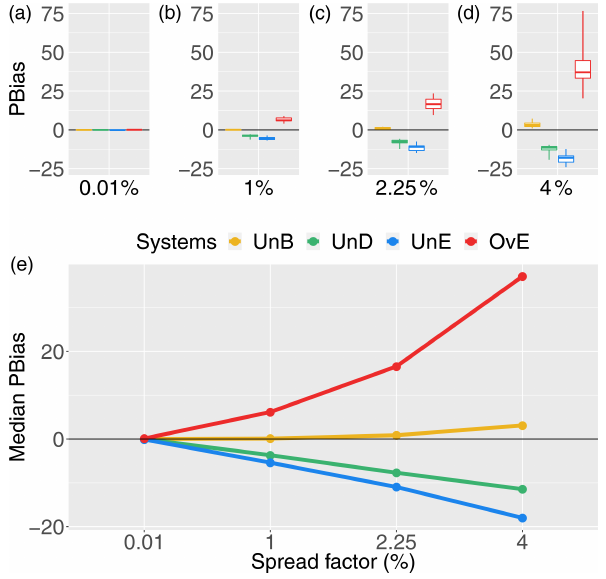
Figure 5. Pbias score for 1d ahead synthetically generated fore- casts of different quality: unbiased system (UnB, yellow), underdis- persed system (UnD, green), underestimating system (UnE, blue) and overestimating system (OvE, red). Systems are based on en- sembles generated with four different spread factors (0.01%, 1%, 2.25% and 4%). (a–d) Boxplots represent the maximum value, per- centiles 75, 50 and 25, and minimum value over the 10 studied catchments. (e) Median score